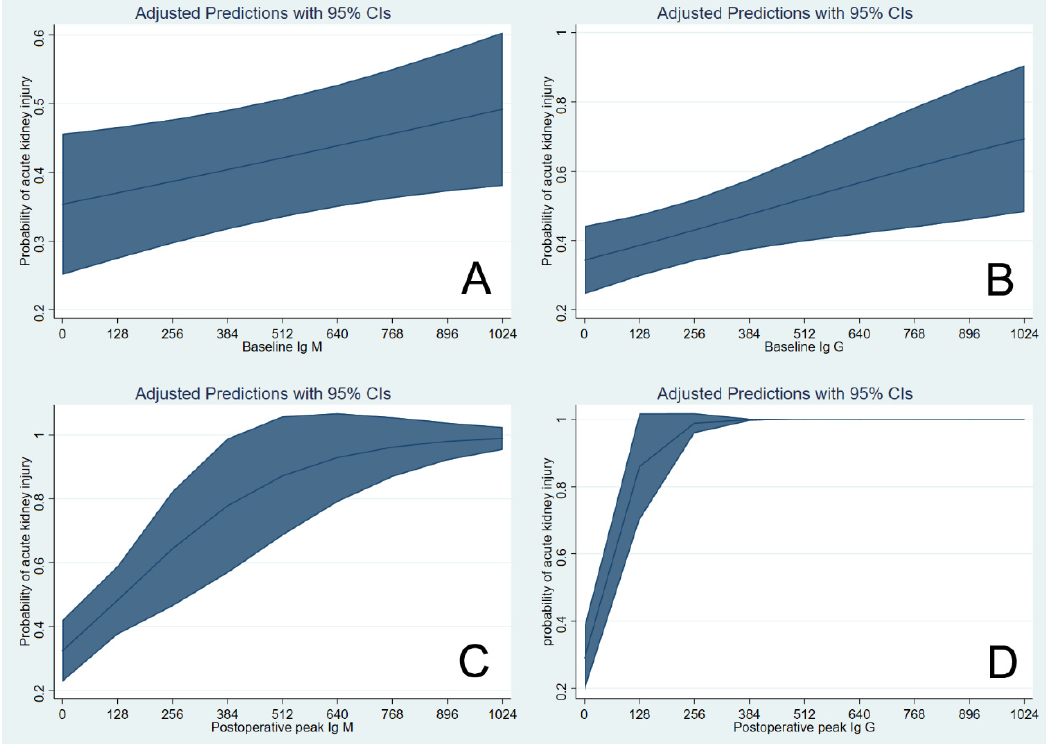
Figure 3. Cubic spline function curve relating initial baseline isoagglutinin titers of Ig M ( A ) and Ig G ( B ) and postoperative peak titers of Ig M ( C ) and Ig G ( D ) to the risk of acute kidney injury in ABO-incompatible liver transplantation. Ig = immunoglobulin. Shaded area represents 95% confidence interval of each estimated probability.